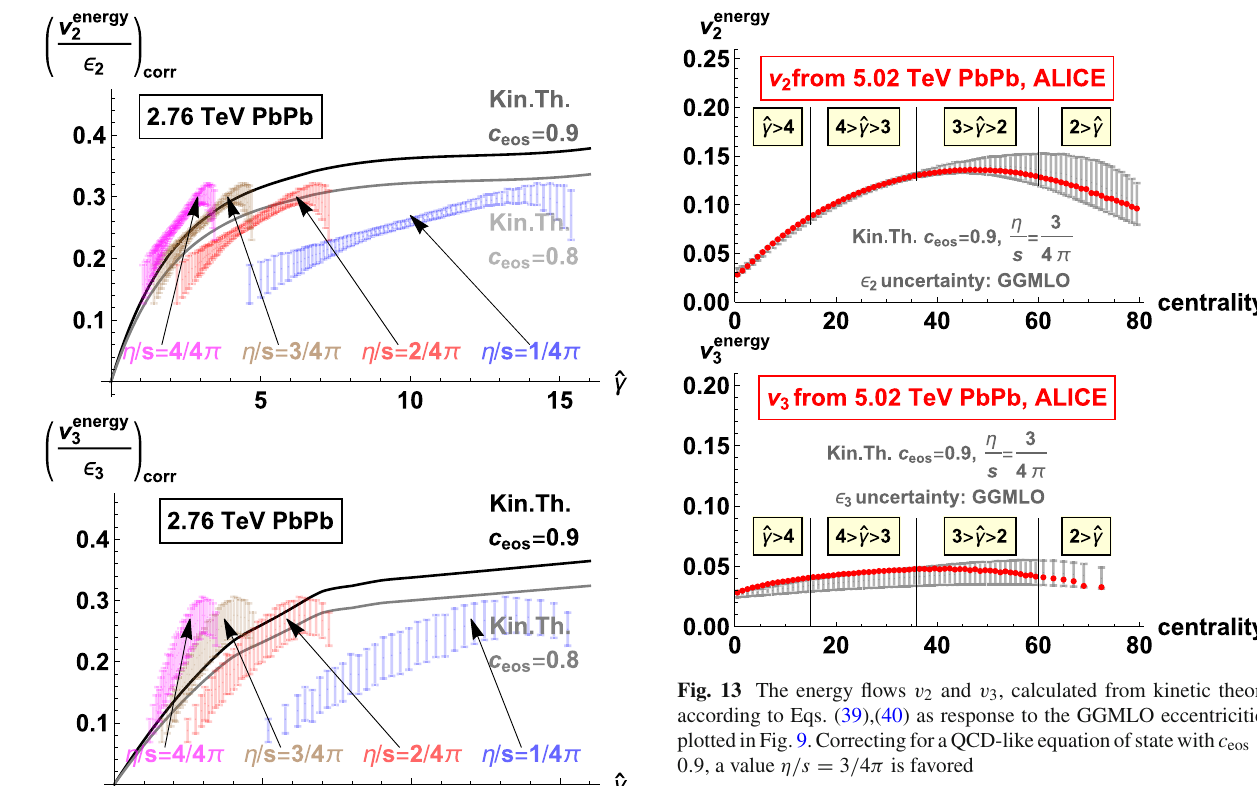
displaying the kinetic theory result of Fig. 5 corrected with c eos = 0 . 8 and 0.9 in both panels.